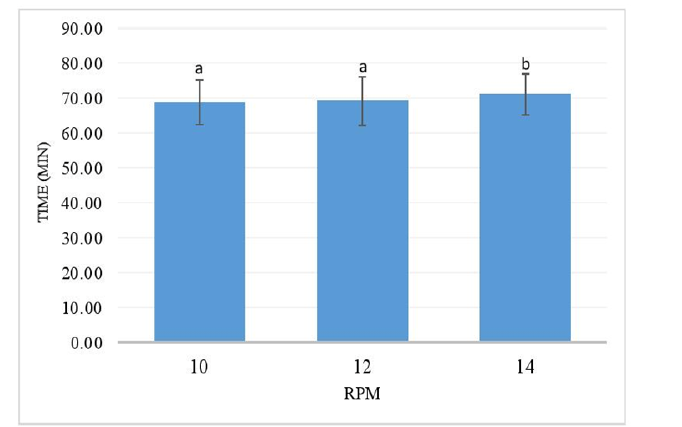
Figure 4: Effect of RPM on Composting Time